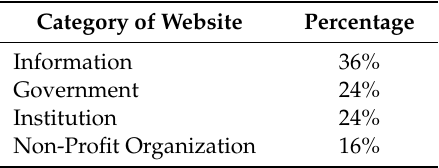
Table 1. Categories of